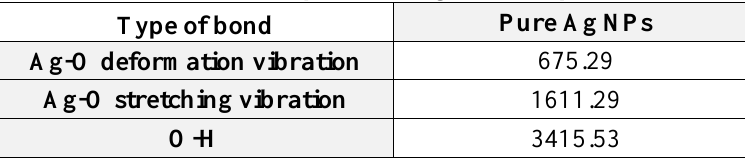
Fig. 3: FTIR pattern for Ag pure thin film. Table 1: FTIR peaks for Ag thin film